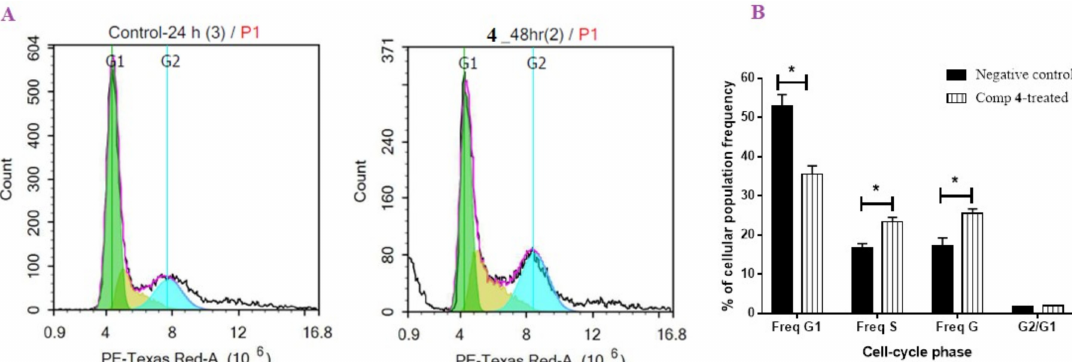
Figure 3. Cytogram reflecting the cell cycle distribution of MCF-7 cells ( A ): MCF-7 cells untreated and treated with compound 4 (23.2 µ M, 48 h); ( B ) bar chart representation of the percentage of cell population in di ff erent MCF-7 cell cycle phases. * p < 0.05 unpaired t -test compared to negative control.